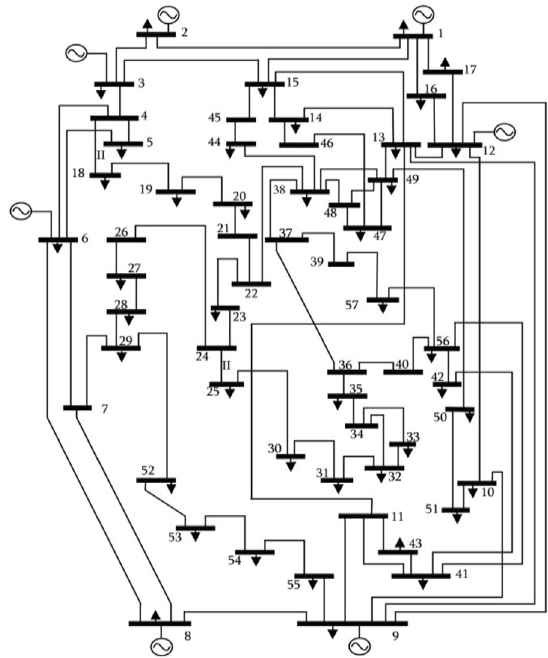
Fig. 2 Structure of IEEE 57 bus system